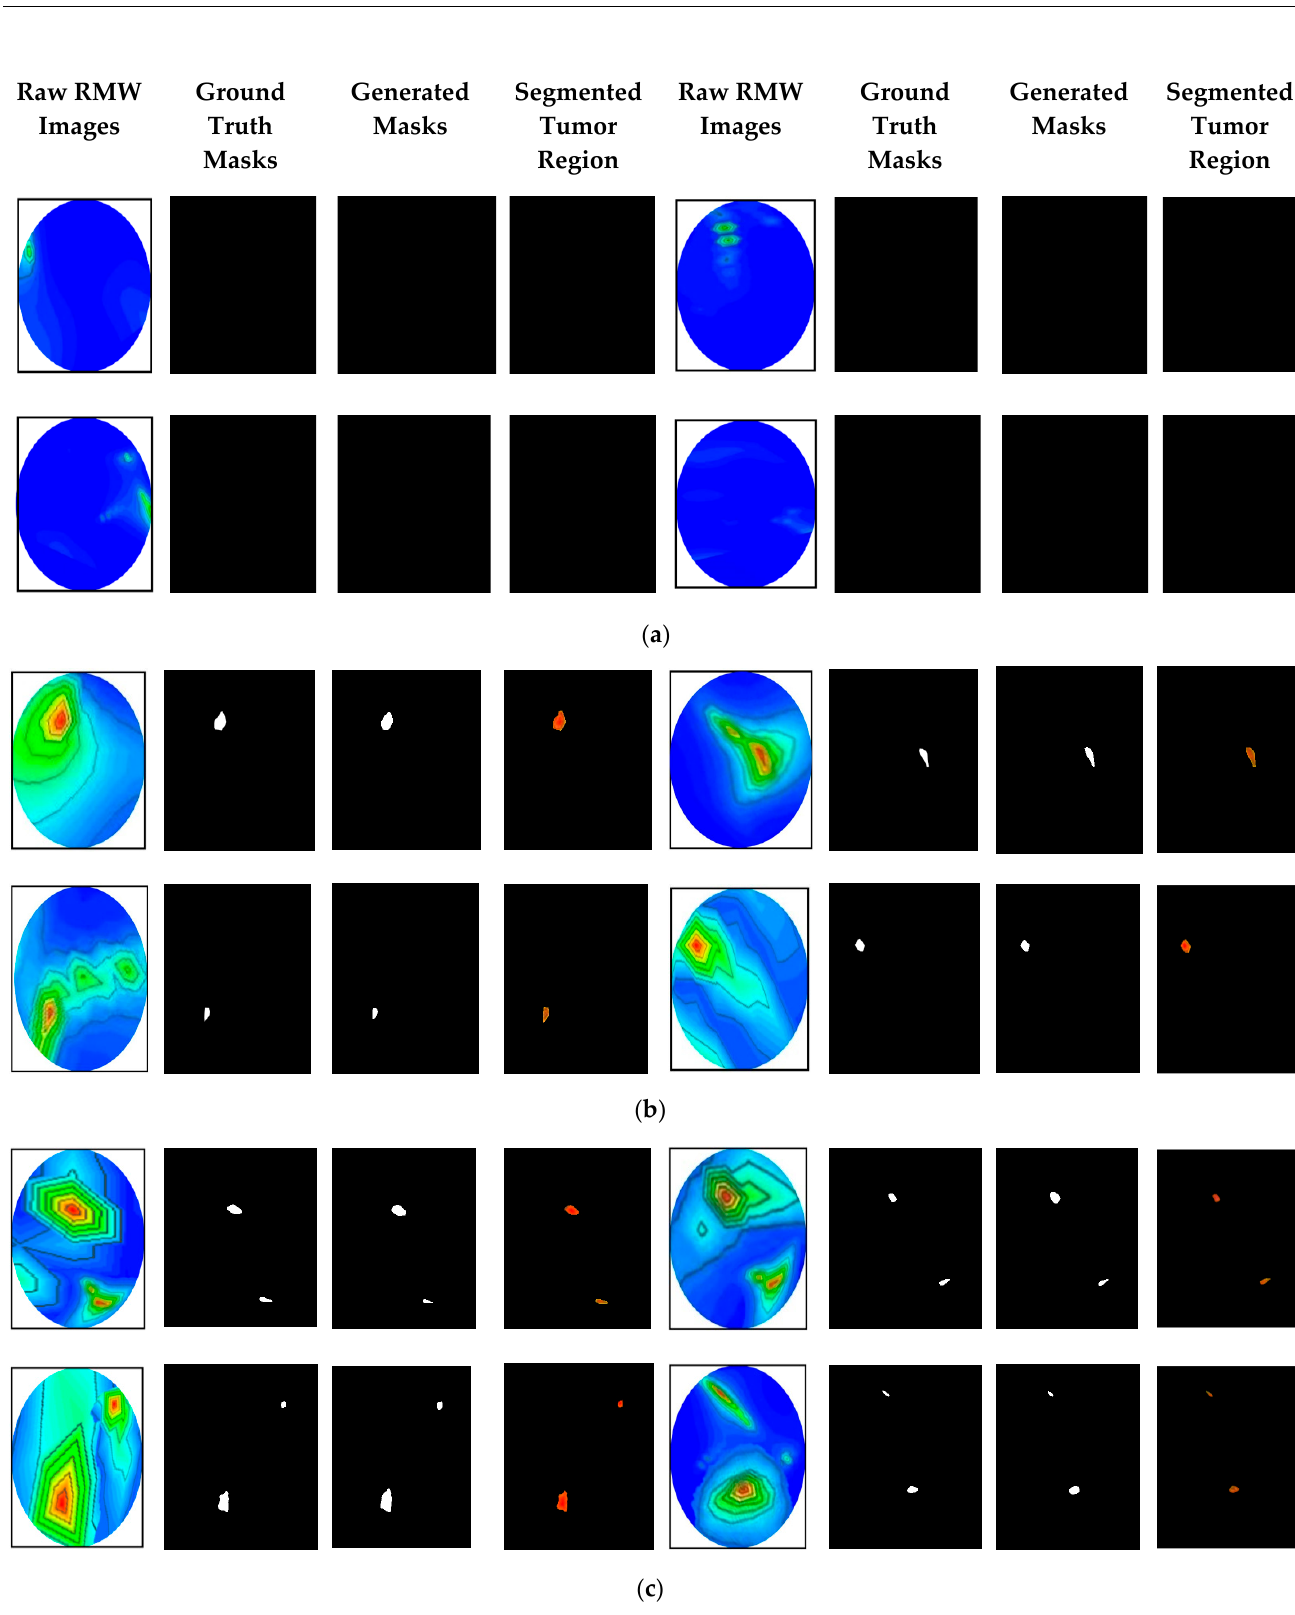
Figure 14. Proposed MSegNet model’s tumor segmentation results with ground truth masks, gen- erated masks, and resultant segmented tumor images for: ( a ) non-tumor class, ( b ) single tumor class, and (c) double tumors class.